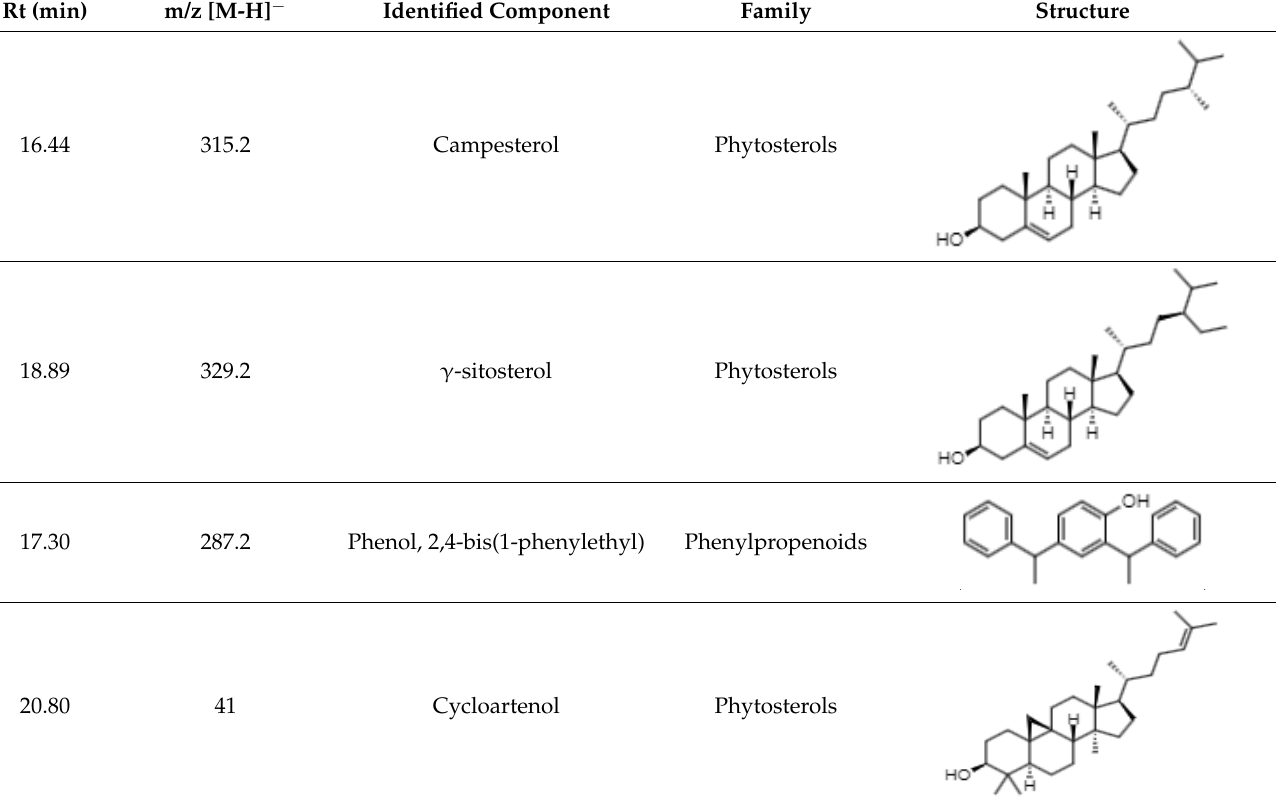
Table 2. Components identified by gas chromatography (CG-MS) in the extract of E. hyemale . Rt, retention time; m/z, mass-to-charge ratio; min, minutes.